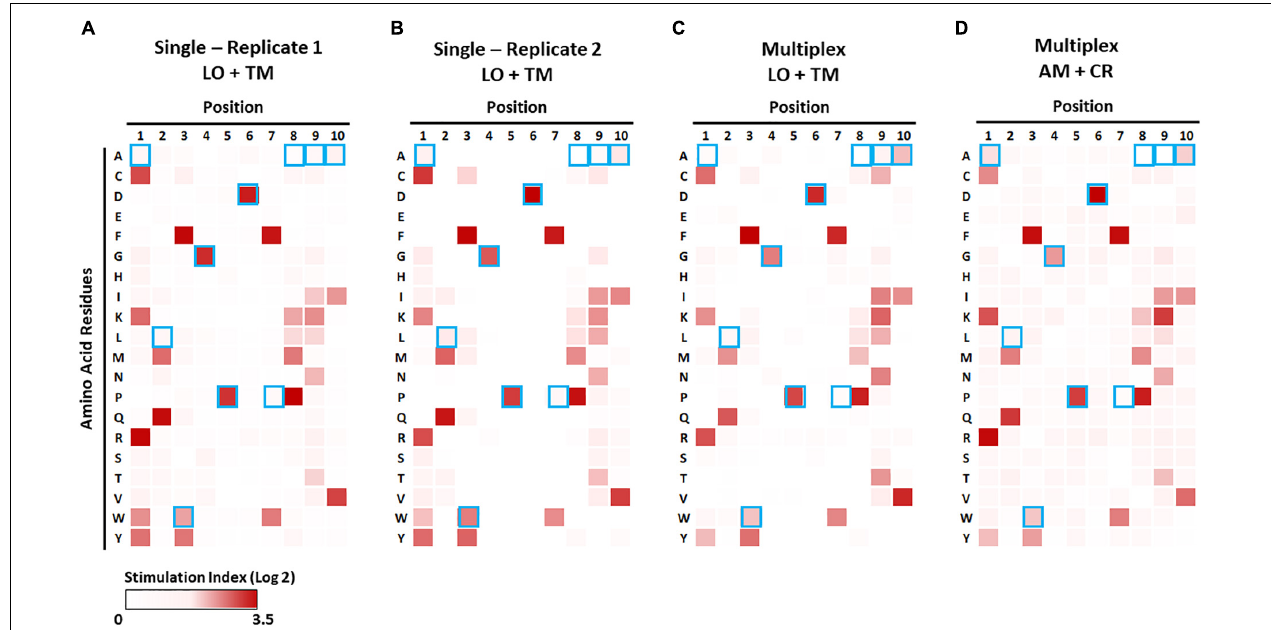
FIGURE 7 | Identification of preferable amino acid residues in epitopes using a combinatorial peptide library (CPL). The CPL consists of 200 decamer peptide pools, each of which contains peptides with a specific amino acid residue at one position and randomized amino acids at the other nine positions ( Supplementary Table S4 ). 1E6 TCR T-hybridoma cells expressing LSSmOrange and tdTomato (A–C) or ametrine and E2-Crimson (D) were co-cultured with each CPL peptide pool along with K562 APCs lentivirally expressing HLA-A2 in the absence [ (A,B) , single test] or presence [ (C,D) , multiplex test] of T-hybridomas expressing irrelevant TCRs and the other seven fluorochrome combinations. Stimulation indexes of 1E6 TCR T-hybridomas in response to the peptide stimulation were calculated as described in Figure 5 based on frequency of ZsGreen-1-positive 1E6 TCR T-hybridoma cells as determined by flow cytometry using the gating strategy shown in Supplementary Figure S2 . Log2 fold changes of stimulation indexes in each culture condition were depicted as heat maps. Results from two independent experiments testing a single T-hybridoma cell line individually are shown in (A,B) . Blue boxes represent the amino acids of the nominal epitope ALWGPDPAAA at each